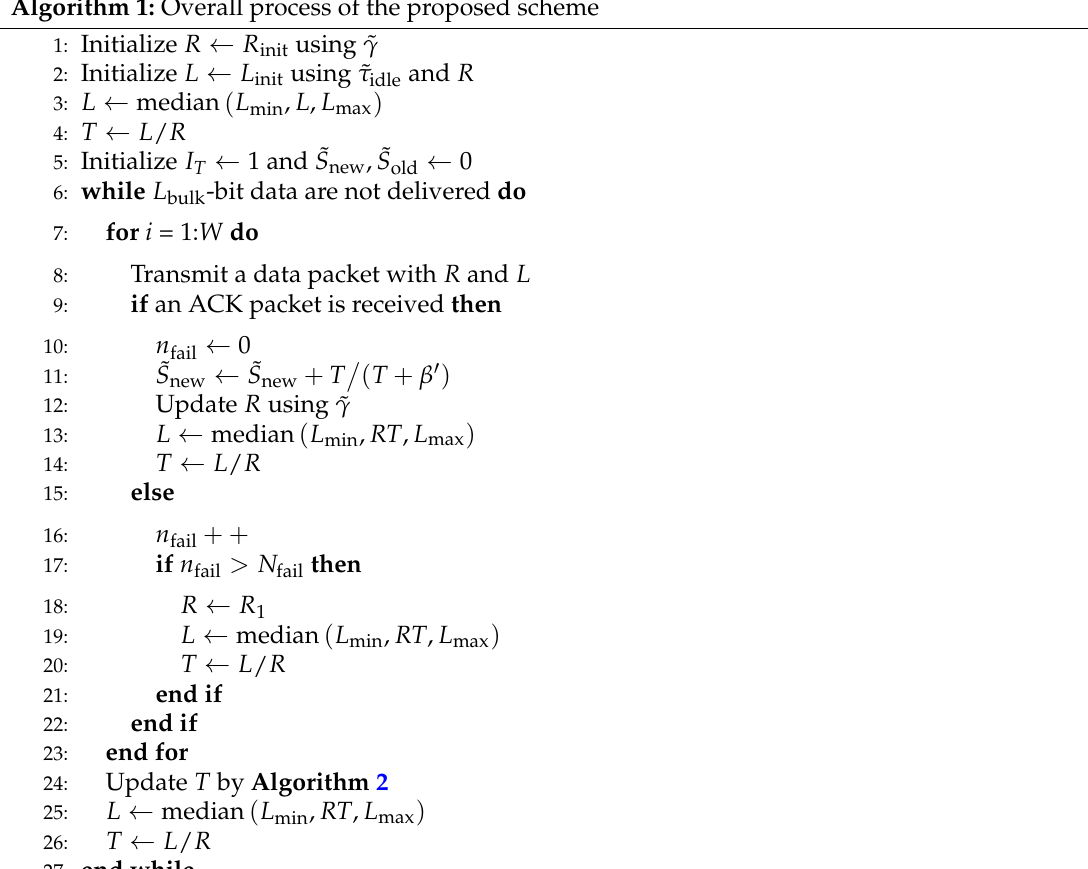
Algorithm 1: Overall process of the proposed